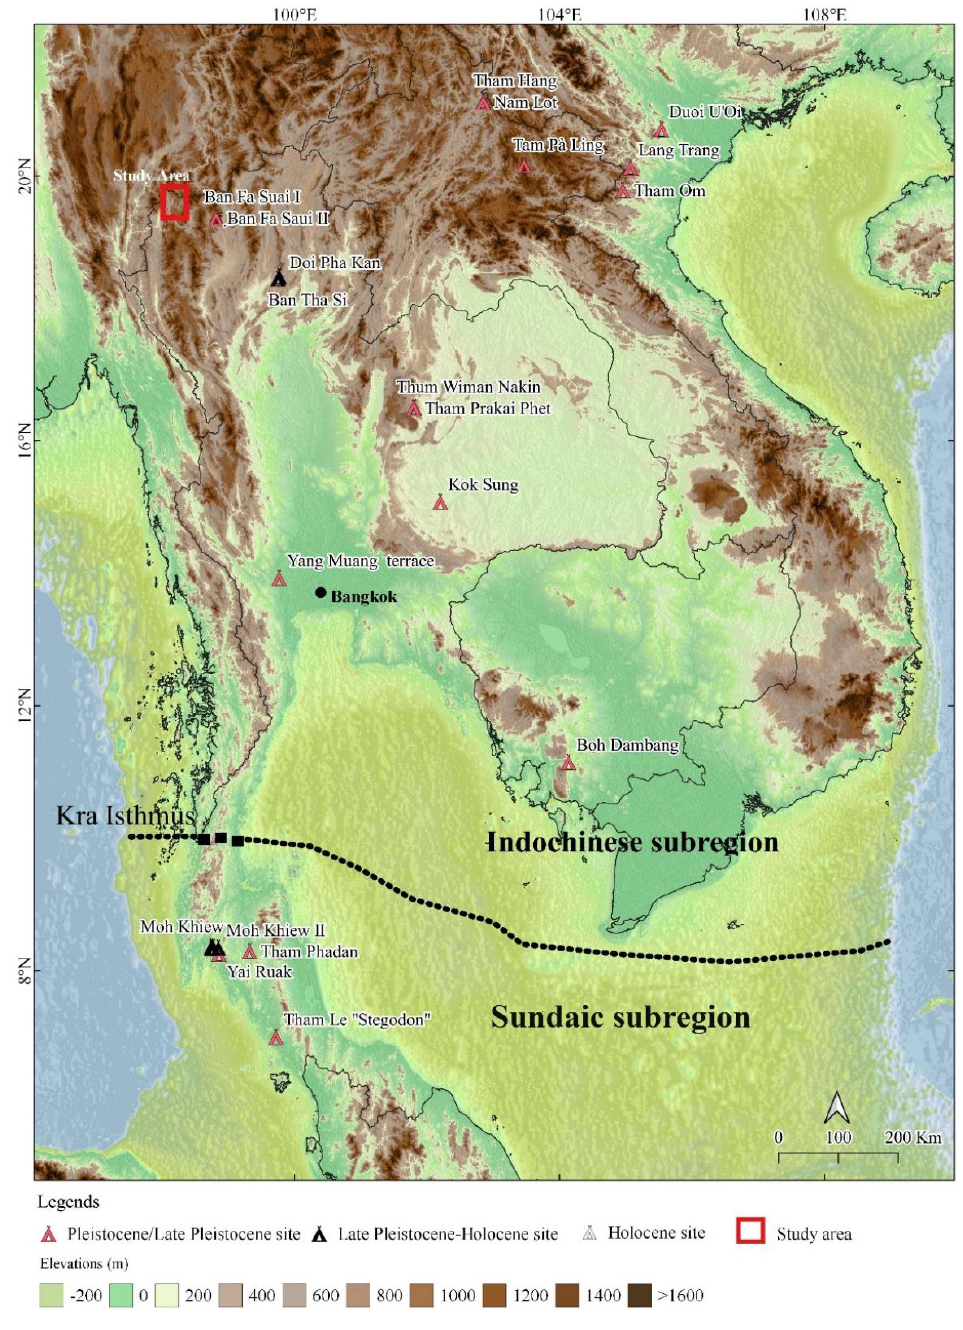
Figure 2. Prominent Pleistocene and Holocene sites in the zoogeographic subregions of mainland and island Southeast Asia (Sundaland) during the Last Glacial Maximum (~21,000 years ago). Sea level depicted at -116 m compared to modern levels [29].